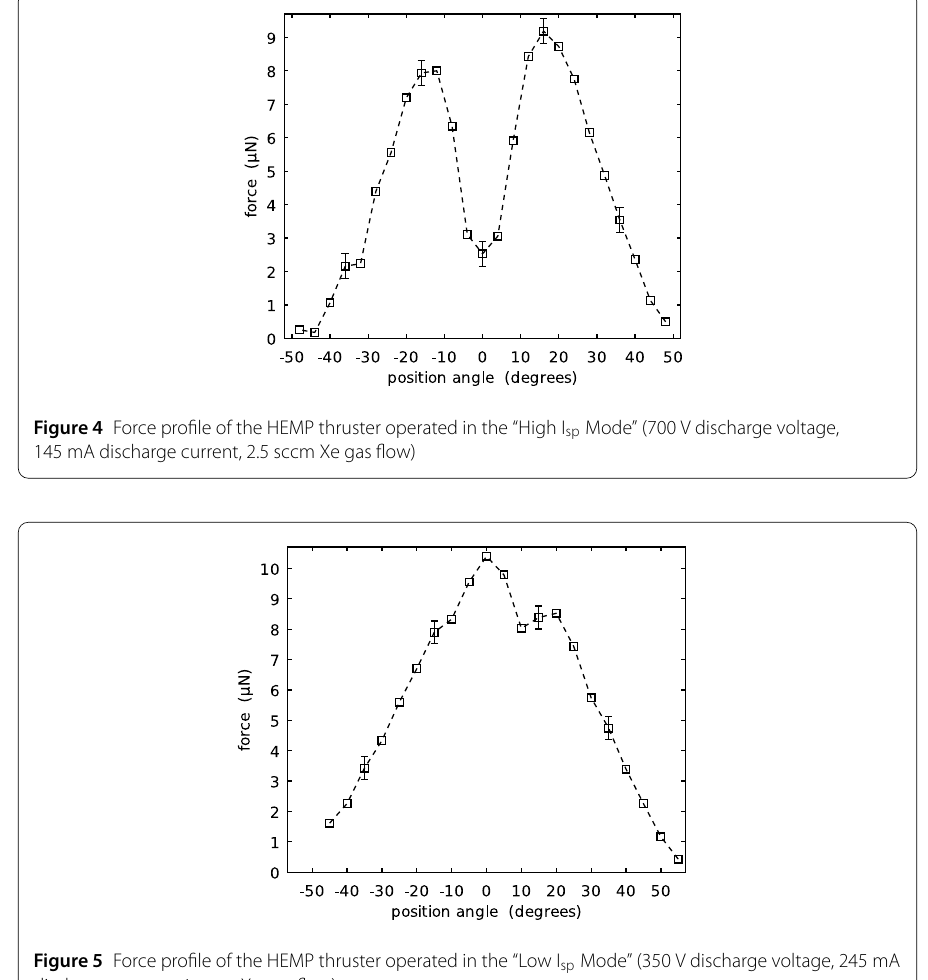
measurements with a HEMP thruster opened up. The two-axes force probe was originally developed for the study of sputtering